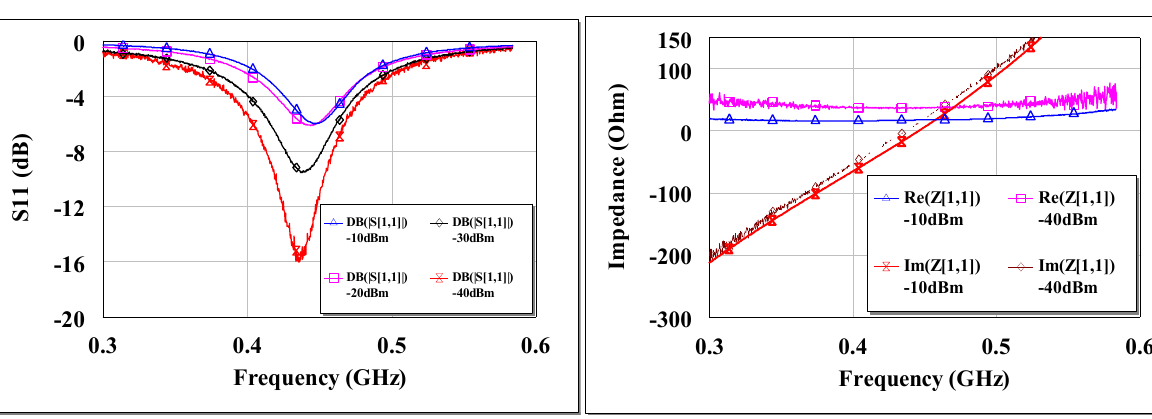
Figure 7. Measured open circuit S of the L-matched Delon circuit at different input 11 power levels from a 50 Ω source ( left ), measured open circuit input impedance at −10 dBm and −40 dBm of the L-matched circuit ( right